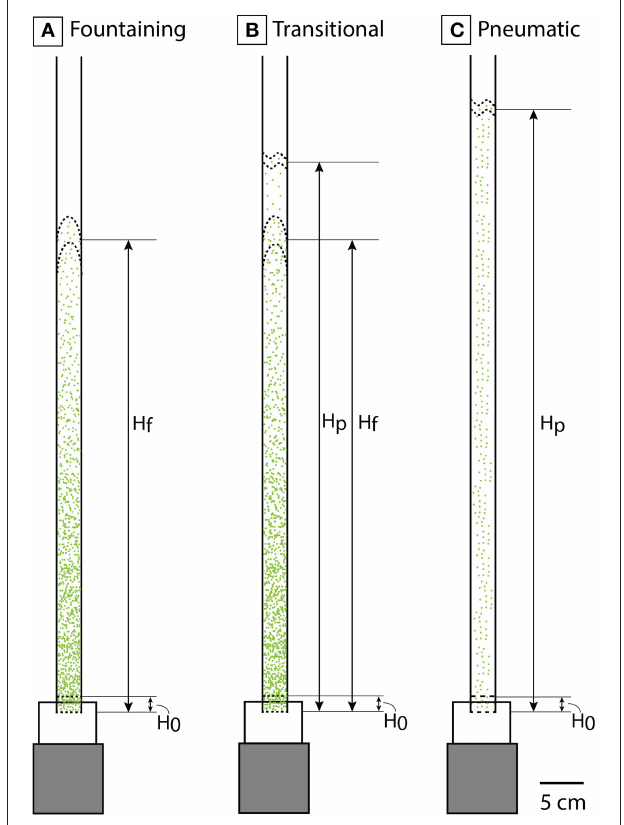
FIGURE 2 | Scaled diagrams of the fluidized regimes observed in this study. (A) Fountaining regime in which bed height ( H f ) pulsates ( average bed height is measured. H 0 is the initial height of the particle bed before air is fluxed through the system. (B) Transitional regime in which a fountaining bed height is present in addition to a pneumatic regime enclosed by H p in which a stable low particle concentration area exists. (C) Pneumatic regime in which particle concentrations are low and particles are homogeneously distributed within the